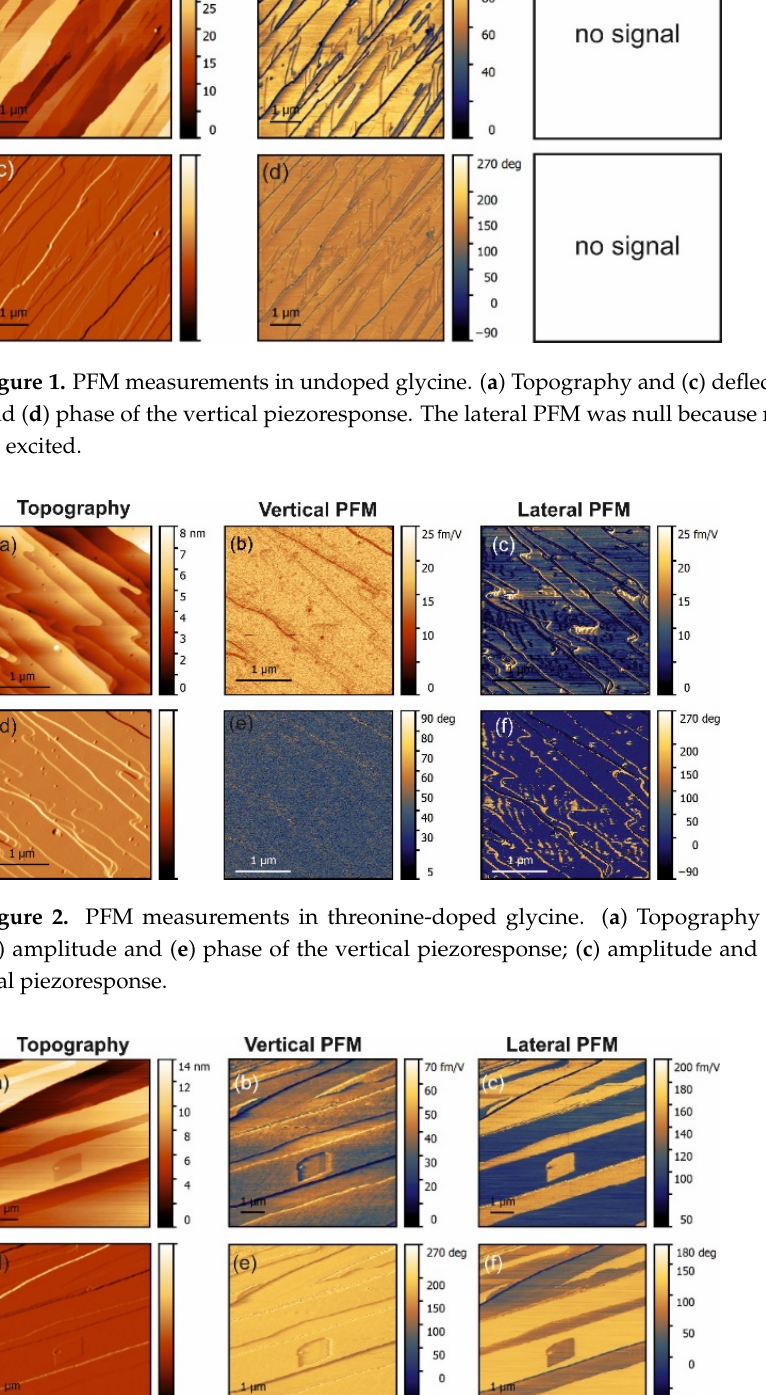
Figure 3. PFM measurements in L ‐ alanine ‐ doped glycine. ( a ) Topography and ( d ) deflection; ( b ) amplitude and ( e ) phase of the vertical piezoresponse; ( c ) amplitude and ( f ) phase of the lateral piezoresponse.